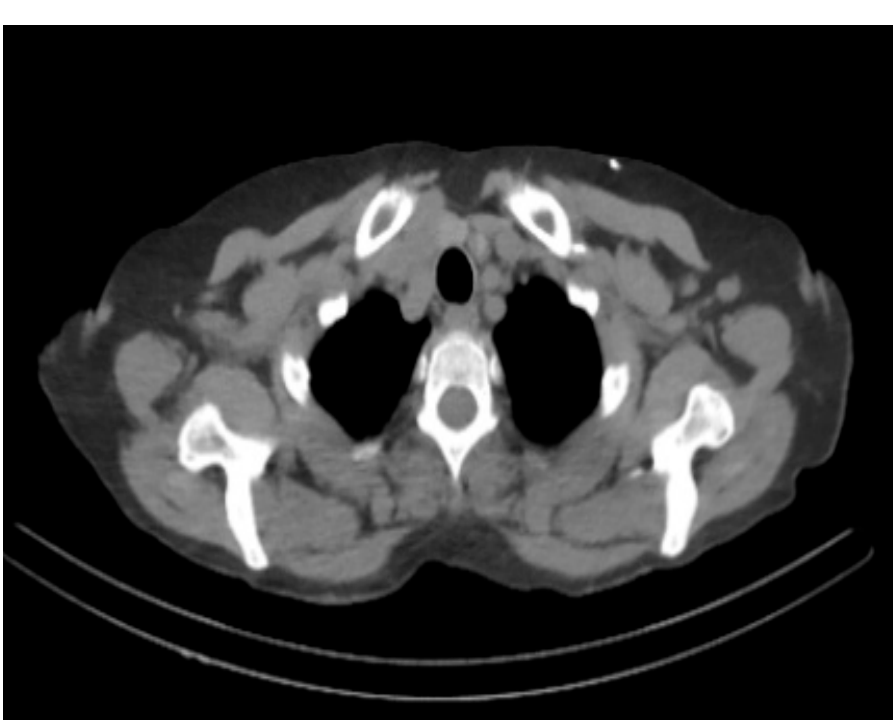
Figure 4. Sample PET scan image showing an Alzheimer’s affected brain. Noted is the size of the enlarged ventricles.